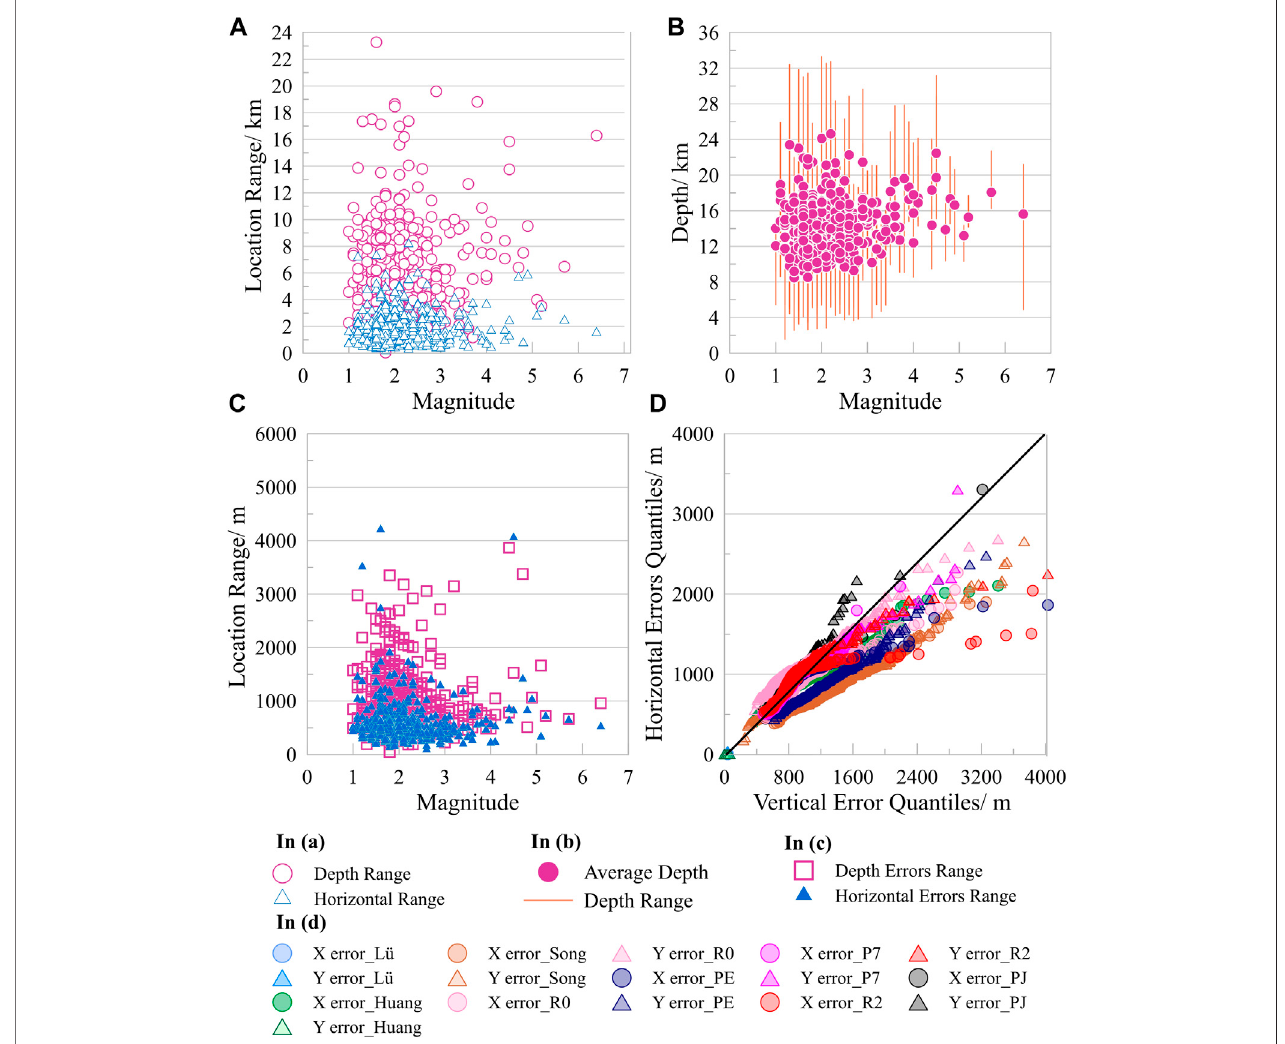
FIGURE 7 | Comparison of the DD locations determined using the eight velocity models. (A) Variation in the horizontal and vertical relocations caused by the differentvelocitymodels.Theredcirclesshowthevariationrangesoftheepicentraldepths.Thebluetrianglesshowthevariationinthehorizontalepicentrallocations. (B) Averages and ranges of the aftershock depths determined using different velocity models. (C) Comparison of the variation ranges of the depth and horizontal errors produced by the 8 velocity models. (D) Quantile – quantile plot of the location errors generated by the different velocity models in the horizontal longitudinal ( X ) and latitudinal ( Y ) directions relative to the vertical location